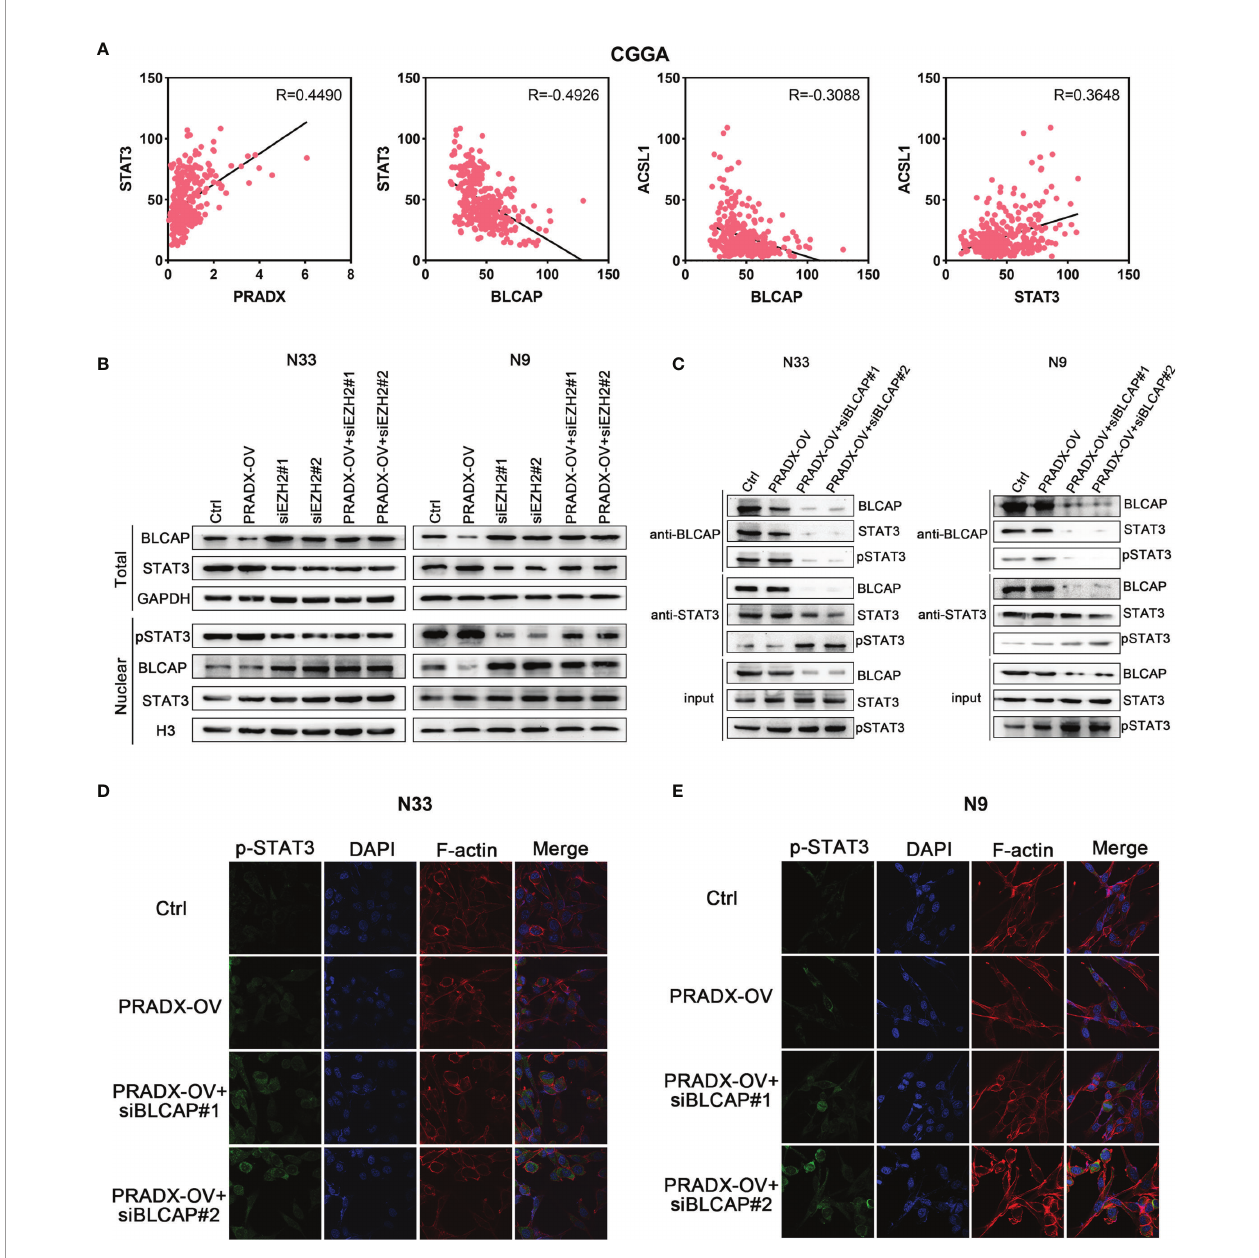
FIGURE 4 | BLCAP interacts with STAT3, and overexpression of PRADX activates the phosphorylation of STAT3 via suppressing BLCAP expression. (A) The correlation between STAT3, PRADX, ACSL1, and BLCAP mRNA expression levels in the CGGA dataset. R, Pearson r value. (B) Western blotting results indicate the total protein levels of BLCAP, STAT3, and GAPDH and nuclear protein levels of p-STAT3, BLCAP, STAT3, and H3 in indicated groups. (C) Co-IP assays were performed with anti-BLCAP or anti-STAT3 antibodies followed by immunoblotting with BLCAP, STAT3, and p-STAT3 antibodies. (D, E) IF staining shows p-STAT3 protein expression and localization in the indicated groups. In (B, C) , GAPDH and H3 served as a positive